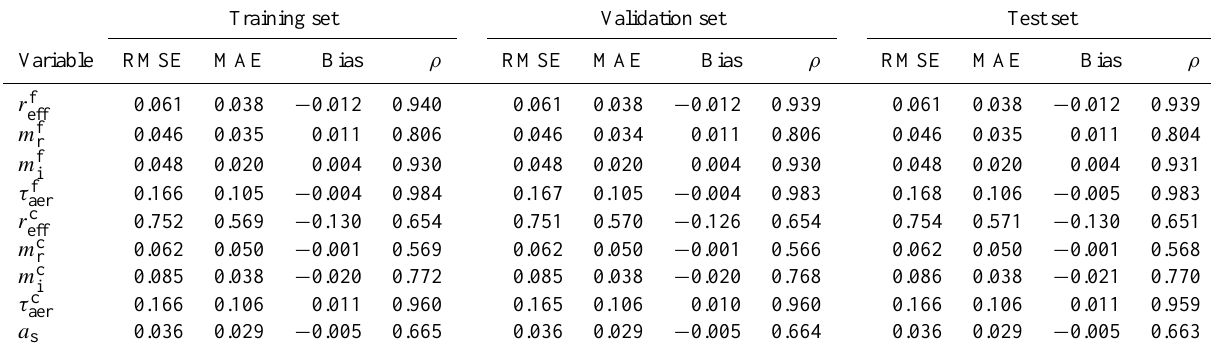
Table 4. Root-mean-square error (RMSE), mean absolute error (MAE), mean bias and Pearson correlation coefficient ( ρ ) between the retrieved and the actual aerosol parameters, computed on the training, test and validation set. Please refer to Table 2 for the meaning of the symbols in the first